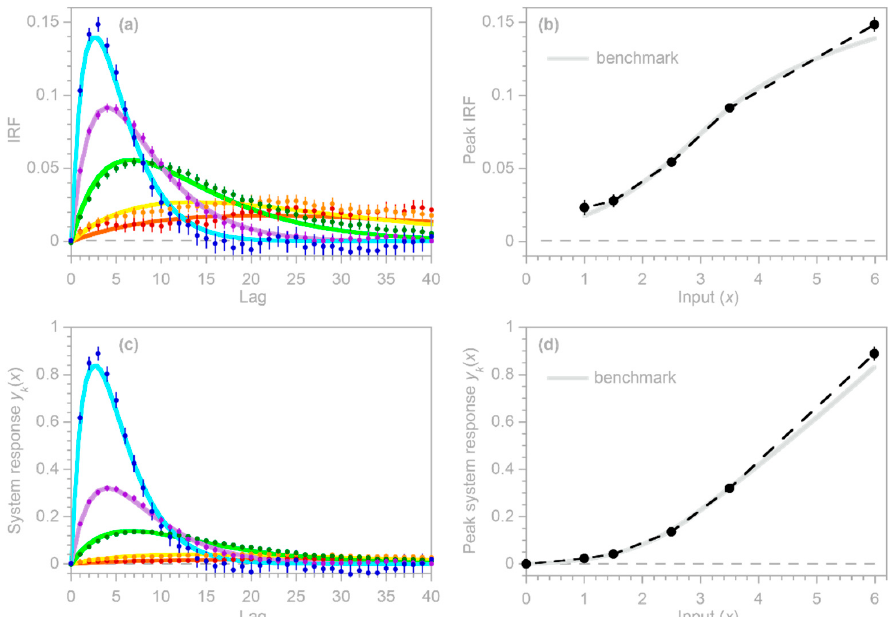
Figure 12. Nonlinear deconvolution of a benchmark impulse response that changes its mean lifetime as a function of the input. Benchmarks (lines) and estimated impulse responses (dots) are shown for a test in which the gamma-distributed benchmark impulse response function’s mean lifetime decreases from roughly 40 at the lowest knot (corresponding to the red curve and dots) to approximately 5 at the highest knot (corresponding to the blue curve and dots). The impulse response functions (system response per unit input) and the system responses themselves, along with their benchmarks ( a , c ), are evaluated at the knots x = κ (cid:96) (in this case, at values of 1, 1.5, 2.5, 3.5, and 6, the highest value of the input x ), indicated by the colors red, orange, green, purple, and blue, respectively. The corresponding peak values of the impulse response function and system response are shown in panels ( b , d ). Error bars show 1 standard error, wherever this is larger than the plotting symbols.